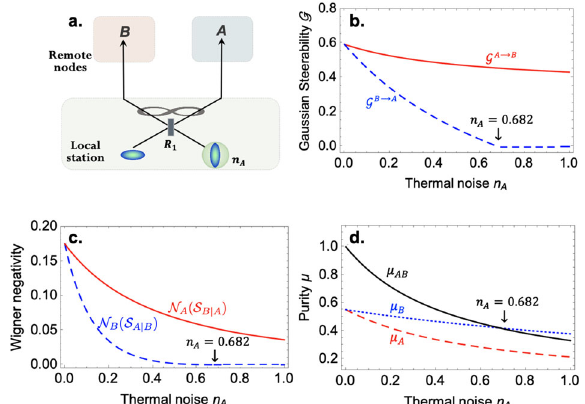
Fig. 5 Remotely generated Wigner negativity and initial Gaussian steering and purity in a noisy bipartite scenario. a Scheme of a two-mode squeezed thermal state with asymmetric thermal noise n A and n B = 0. b The initial asymmetric Gaussian steerability with fi xed squeezing level of r = 0.6 (corresponding to − 5.2 dB quadrature noise), where thermal noise has a more signi fi cant effect on the steered mode. c Corresponding to b , after the single-photon subtraction on one side, the remotely generated Wigner negativity of the other side. d The local and global purities of the initial Gaussian